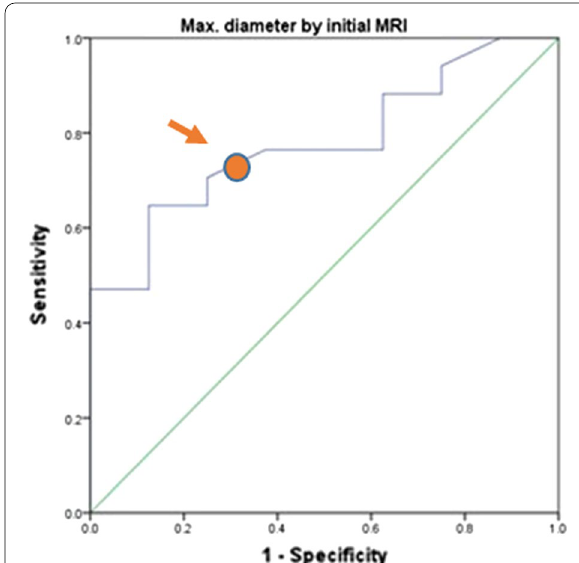
Fig. 5 ROC curve analysis for pathologic response prediction using Max. Diameter by initial MRI (Best cut off value for Max. Diameter by MRI 1 4.25 with sensitivity 70.6% and specificity 75.0%). The area = = = under the curve is 77.9% (95% confidence interval =